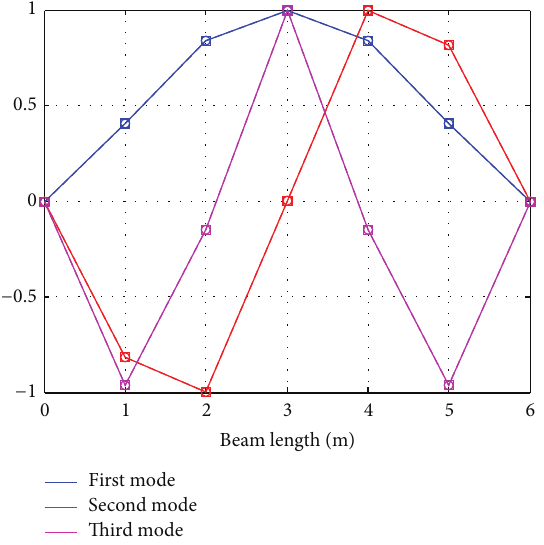
Figure 2: Mode shapes of undamaged structure.